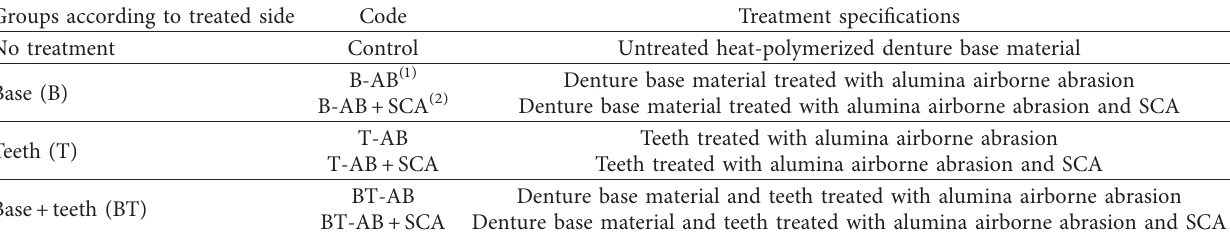
Table 1: Specimen grouping and specifications.